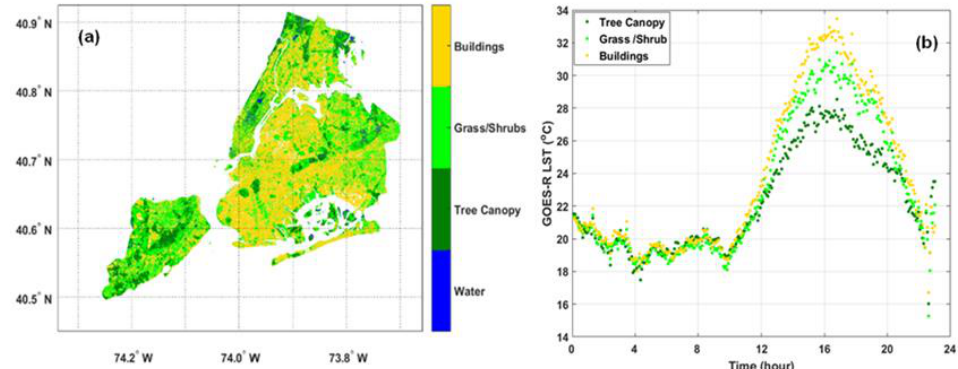
Figure 2. ( a ) Major land cover types over New York City based on 2010 New York City Open Data, and ( b ) diurnal cycle of GOES – R LST in July 2017 across New York City for three major land cover types, e.g., tree canopy, grass/shrub, and